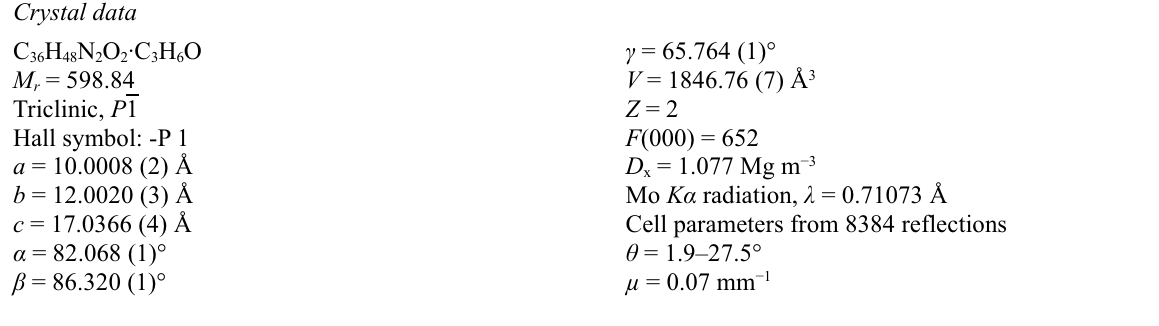
Part of the crystal packing of the title compound, showing a C—H··· π bonded (dashed lines) chain along the a axis. For clarity, the solvent molecules and H atoms not involved in the interactions have been omitted. 4,4 ′ ,6,6 ′ -Tetra- tert -butyl-2,2 ′ -[1,2- phenylenebis(nitrilomethylidyne)]diphenol acetone